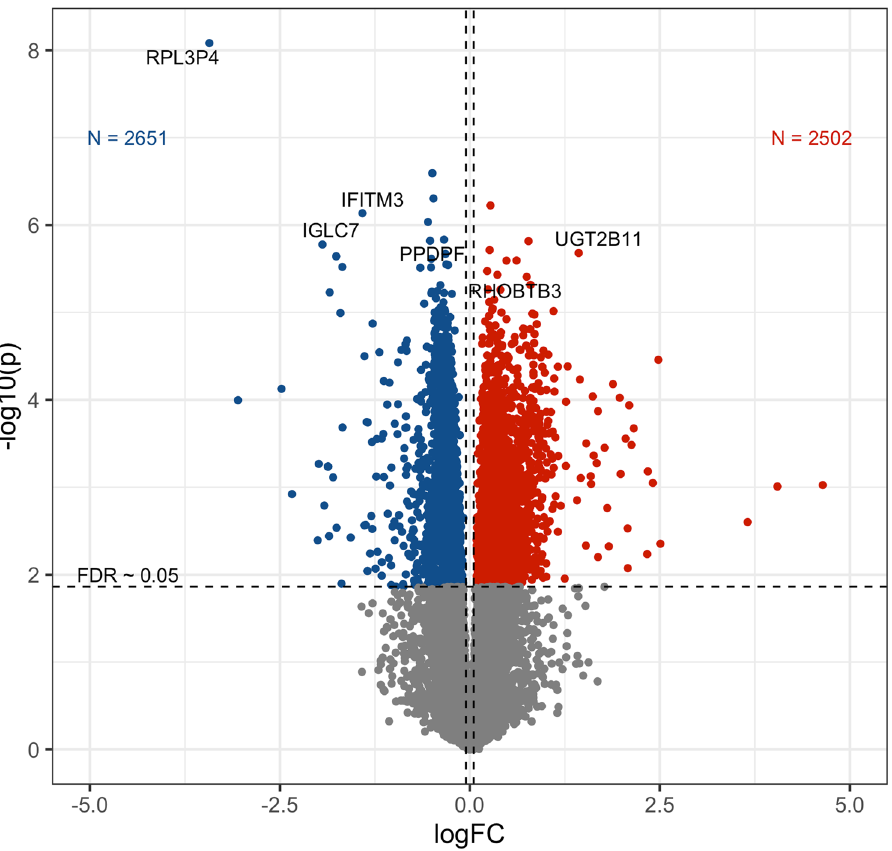
Figure 2. Volcano plot showing variation of significance and log-fold-change for age-adjusted differential gene expression